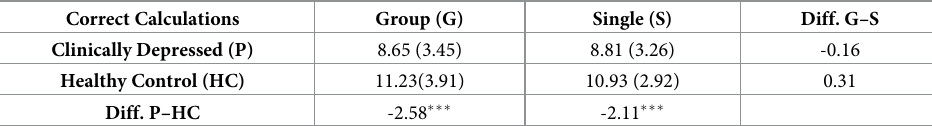
Table 11. Individual performance by treatment.